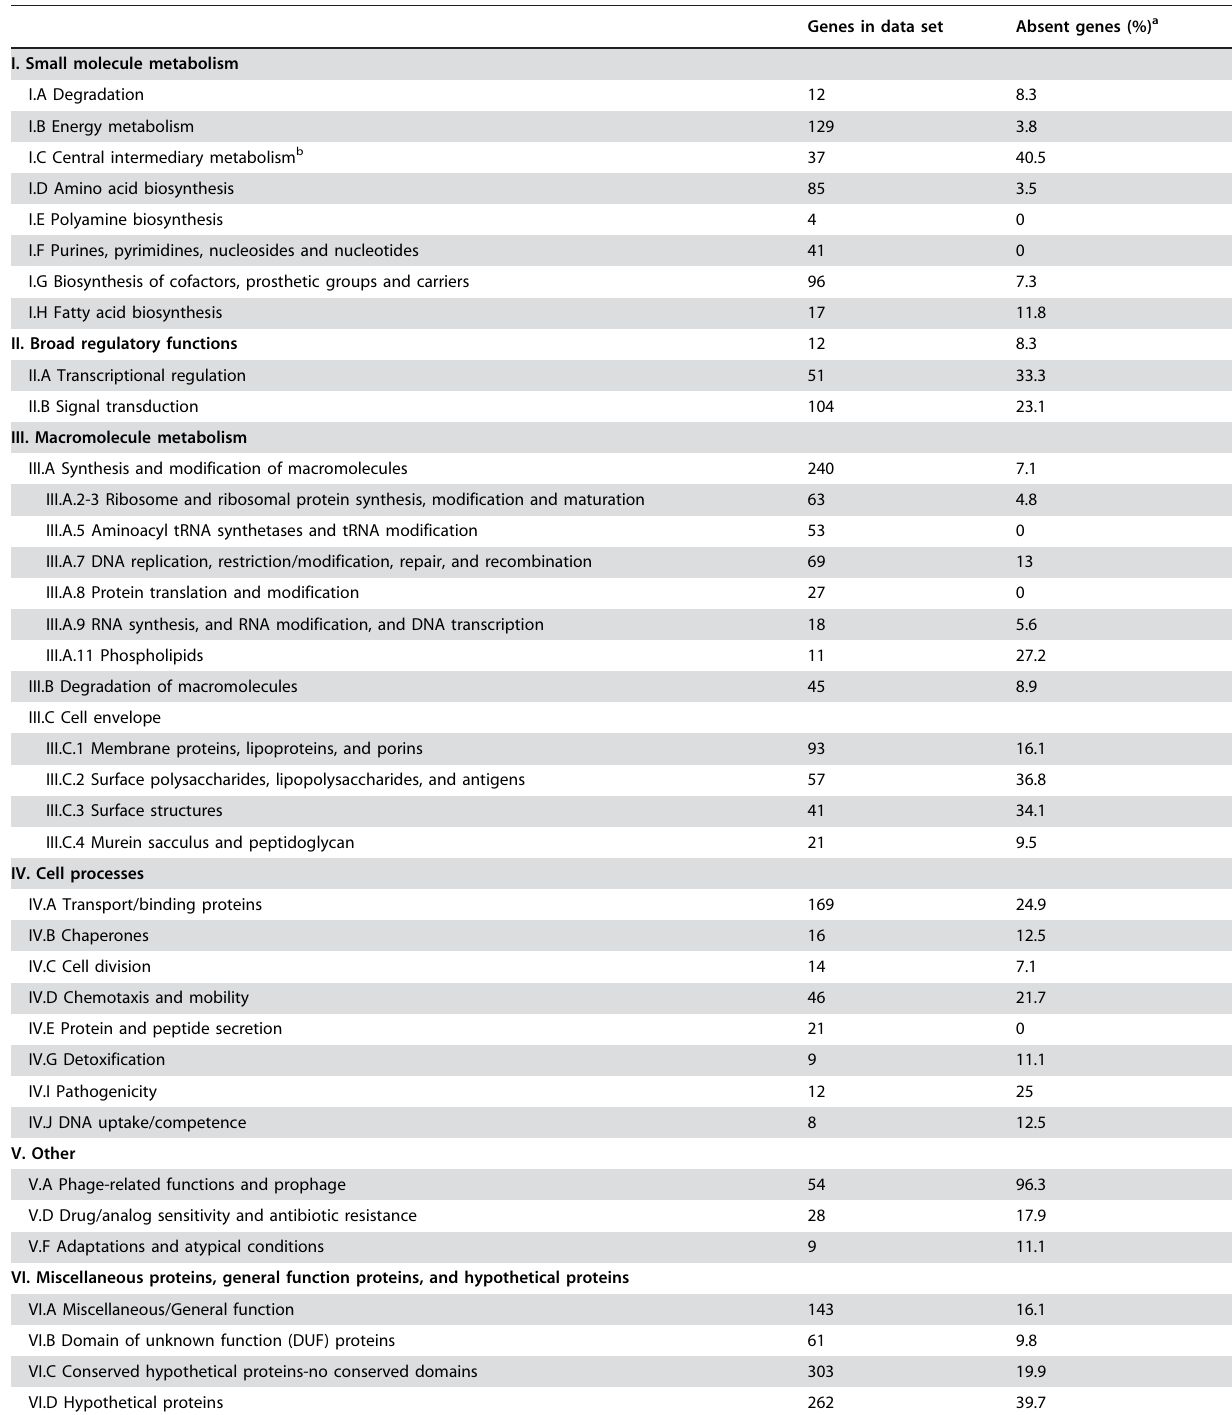
Table 5. Assignment of absent CDS to functional categories of A. butzleri . .. ... .... ... ... .... ... ... .... ... ... .... ... ... .... ... ... .... ... ... .... ... ... .... ... ... .... ... ... .... ... ... .... ... ... .... ... ... .... ... ... .... ... ... .